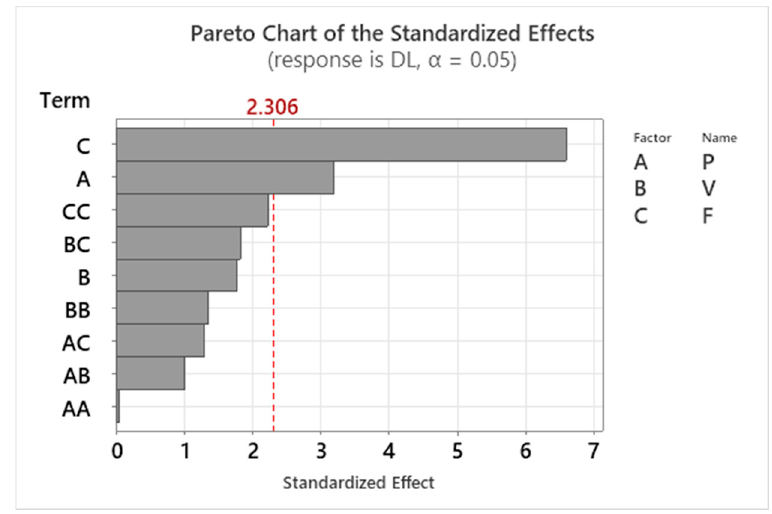
Figure 10. Pareto chart (significance level, α = 0.05) of the standardized effects of process parameters on dilution.